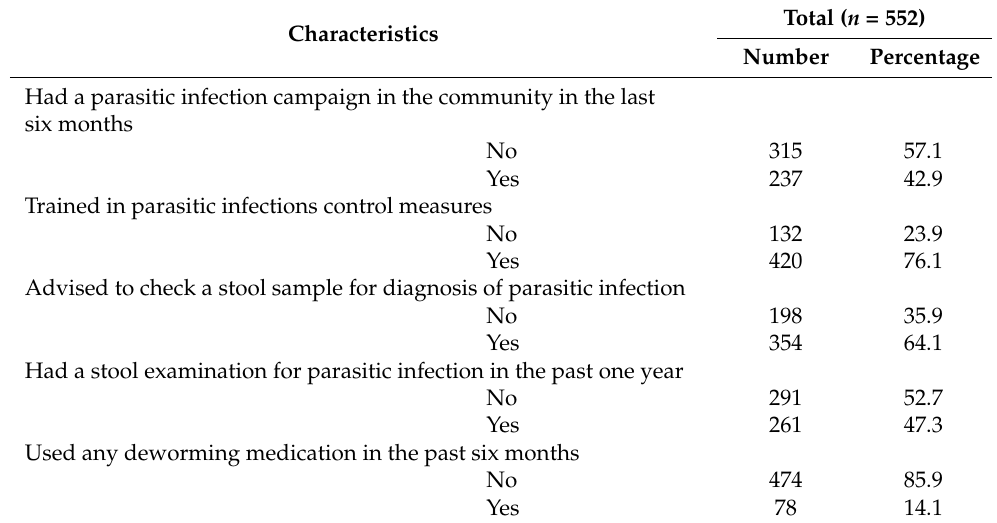
Table 2. VHVs’ experience with parasitic control measures. Characteristics